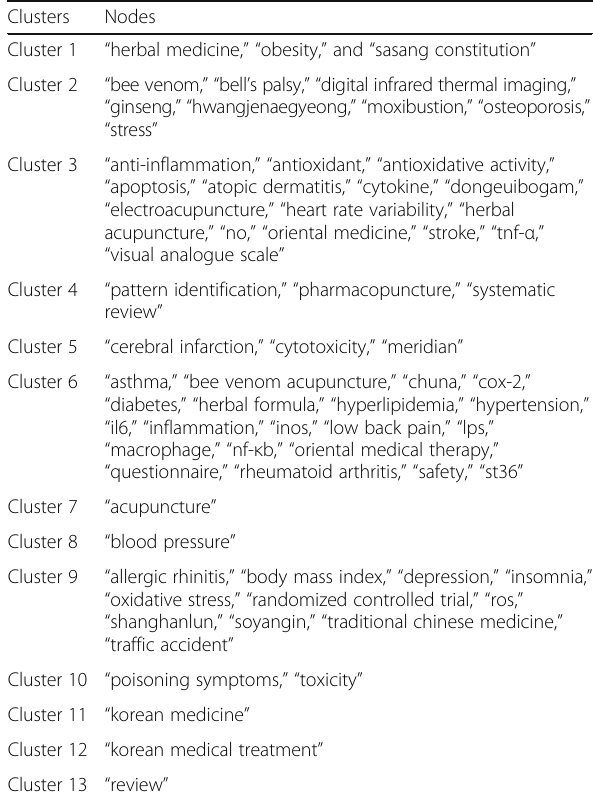
Table 3 Distribution of the nodes in each